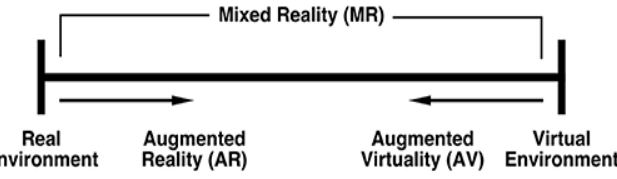
Figure 1. Reality–Virtuality Continuum.